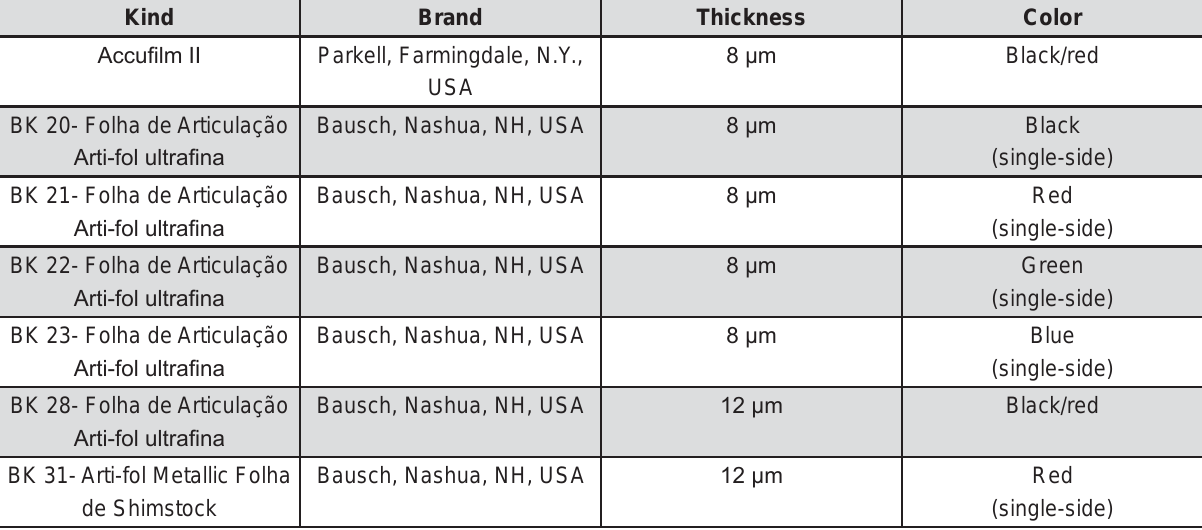
Figure 1- Occlusal contact registration strips (OCRS) used to record occlusal